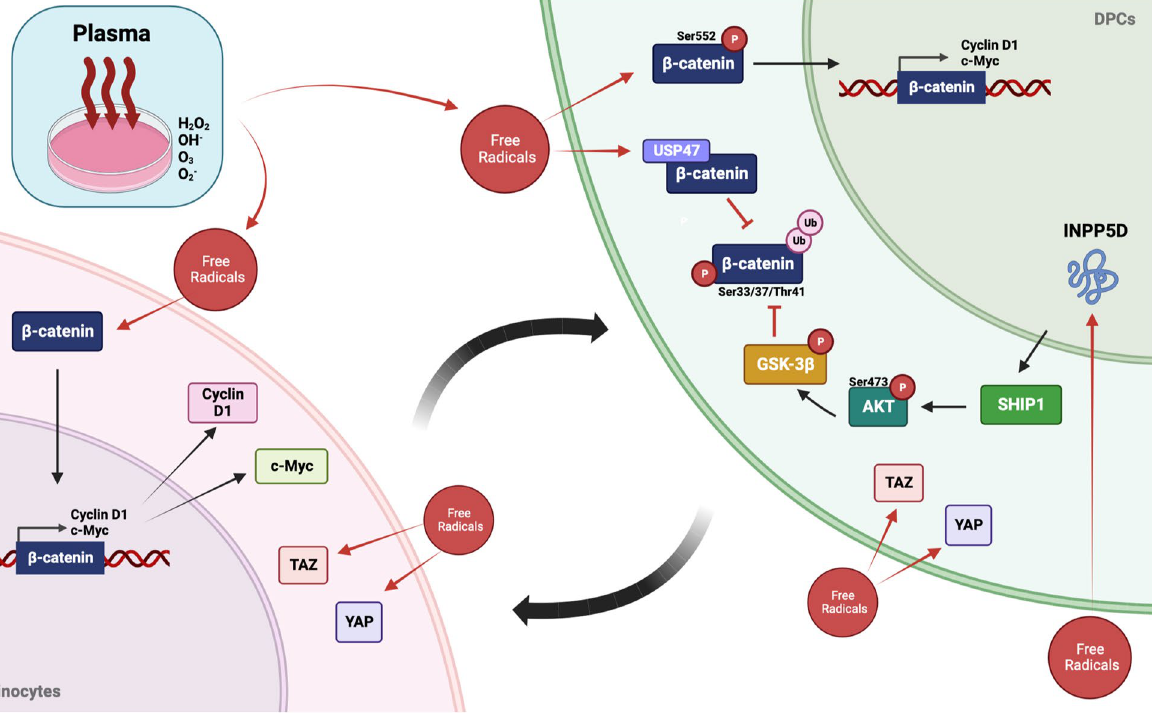
Figure 6. A schematic representation of the proposed molecular mechanisms of CAMP promoting hDPCs